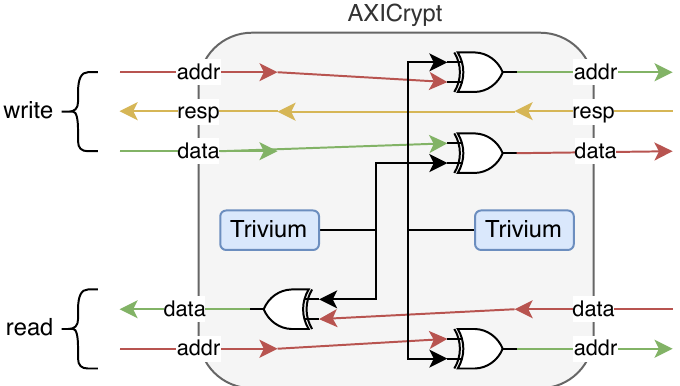
Figure 2. The designed IP has two separate and optional sections, address encryption and data encryption. Both parts are built around a 64-bit Trivium core. The IP core also manages VALID and READY signals when the encryption core is being initialized.